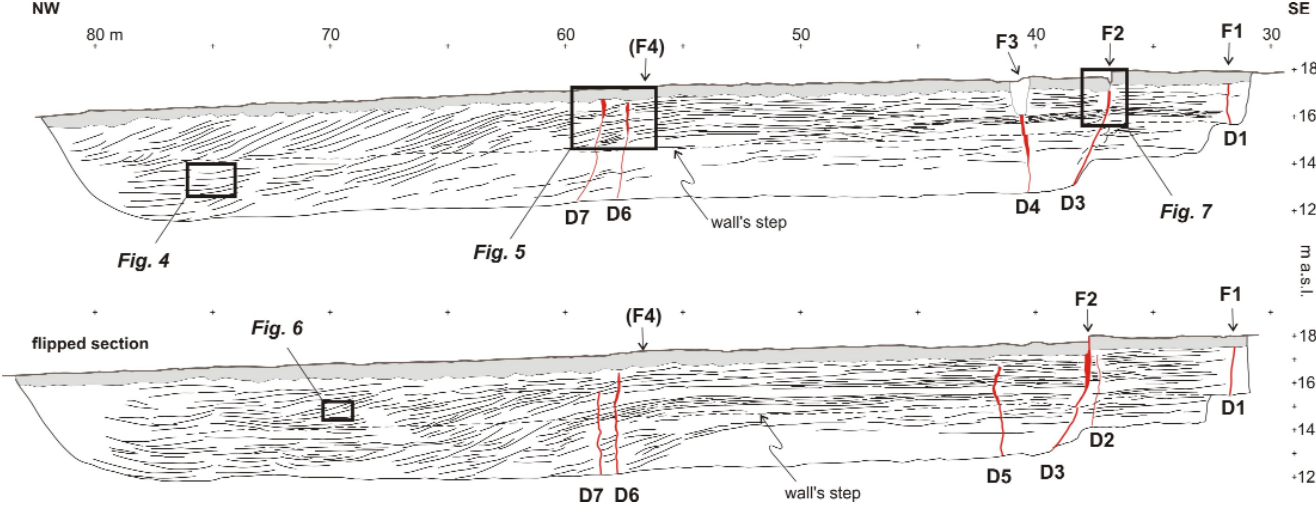
Figure 3. Trench logs (SW wall flipped) showing the intersection of the ground ruptures (F) with the walls, the location of the sand-filled dikes (D), and the stratigraphic framework. The three-dimensional view of the dikes in the trench allows recognition of D4 and D5 as two distinct overstepping struc- tures. The vertical scale is in meters a.s.l. No vertical exaggeration was